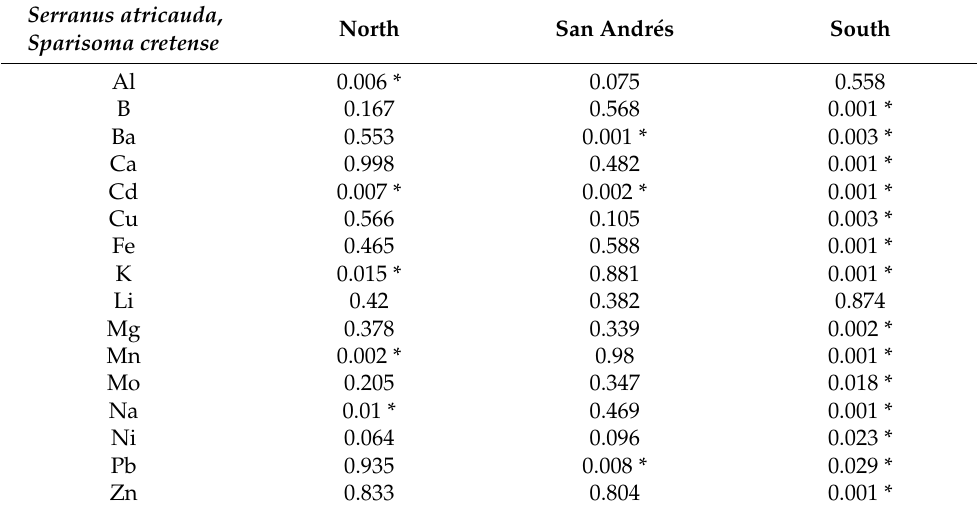
Table 9. Results of pairwise tests examining the significant factor of ‘Zones’ obtained in the two-way PERMANOVA analyzing the variation in the content of heavy metals and trace elements in liver tissue in species according to study zone, considering the level of the factor